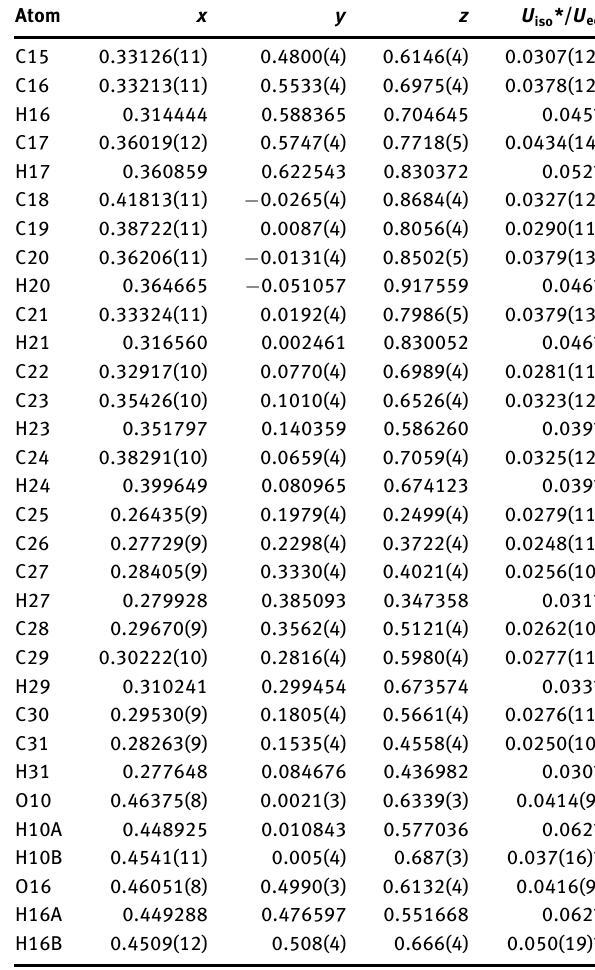
Table 2: Fractional atomic coordinates and isotropic or equivalent isotropic displacement parameters (Å 2